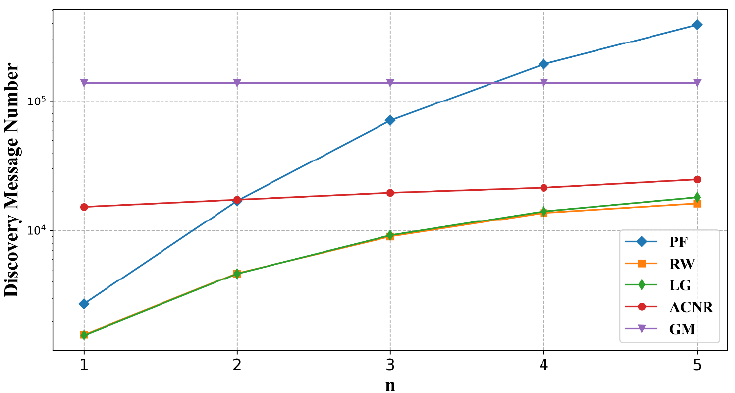
Figure 4. Discovery message number comparison for each algorithm with different discovery rounds at a network size of 1500.